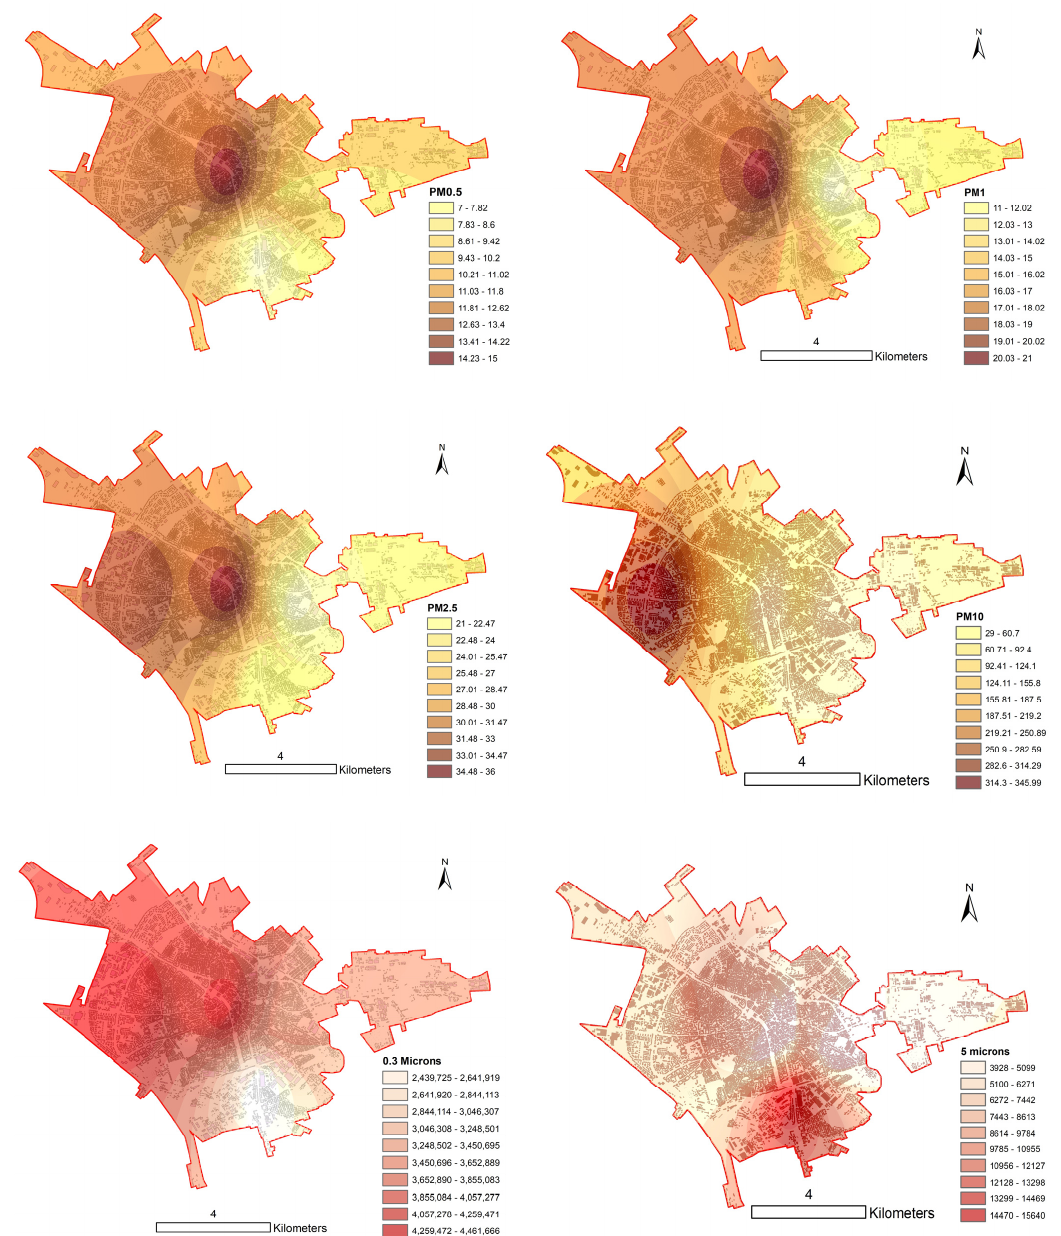
Figure 4. Interpolation maps estimating the spatial distribution of the concentrations of various PM fractions (µg m − 3 ) and particle number concentration (between 0.3 and 5 micron particles—particle number/cm 3 ) in the morning for a day, characterized by a PM pollution episode (>30 µg m − 3 PM2.5 24 h average) and based on the measurements performed with the particle counter during the monitoring campaigns.